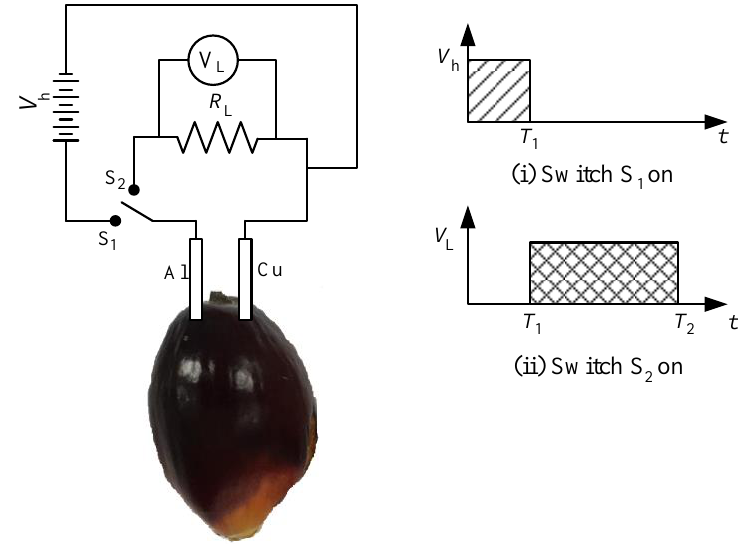
Figure 3. Schematic diagram of fruit battery circuit with charging concept.